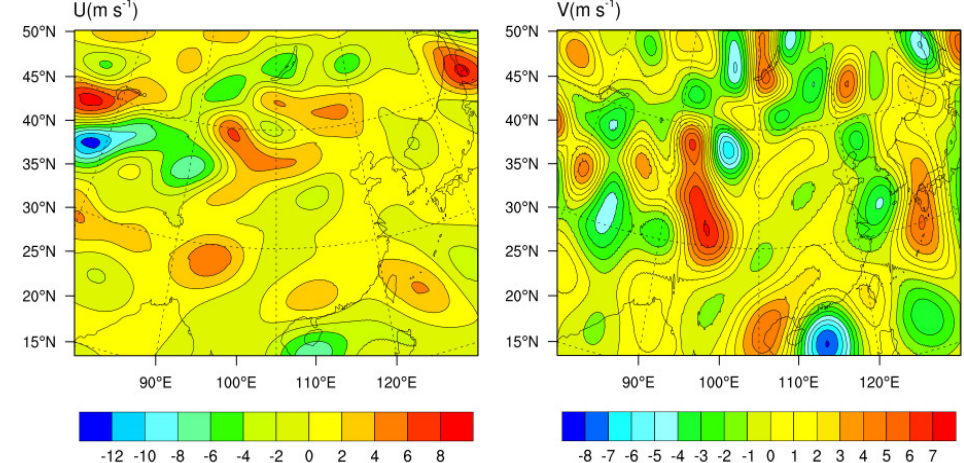
Figure 6. Analysis increment of the U and V wind at 00 UTC 20 July 2021 for the level of about 300 hPa in the experiment with the QI > 80 AMV data (left, U wind; right, V